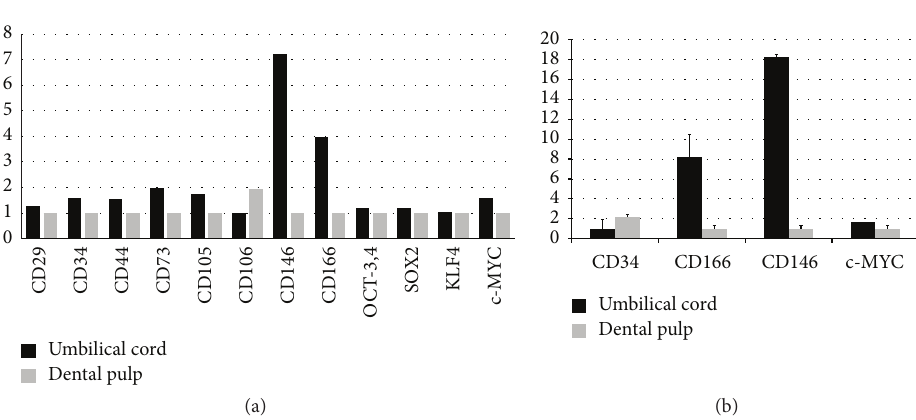
Figure 2: Relative gene expression of mesenchymal stem cell and induced pluripotent stem cell markers using cDNA microarray (a). The relative differences in the expression of stem cell markers between umbilical cord and dental pulp were analyzed using qRT-PCR (b). Data are presented as means ± standard deviation and expressed as the relative change by applying the equation 2 −Δ Ct , where Δ Ct = Ct of the gene minus Ct of the 18S